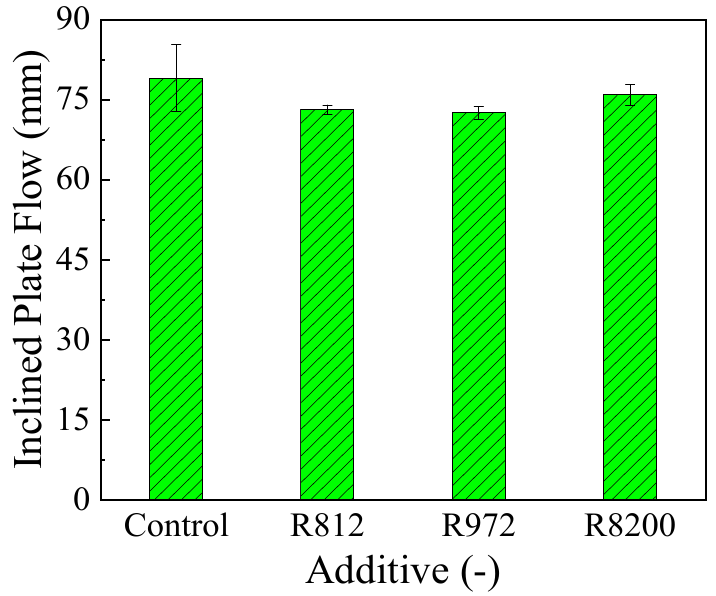
Figure 10. Inclined plate flow of polyester powder samples.